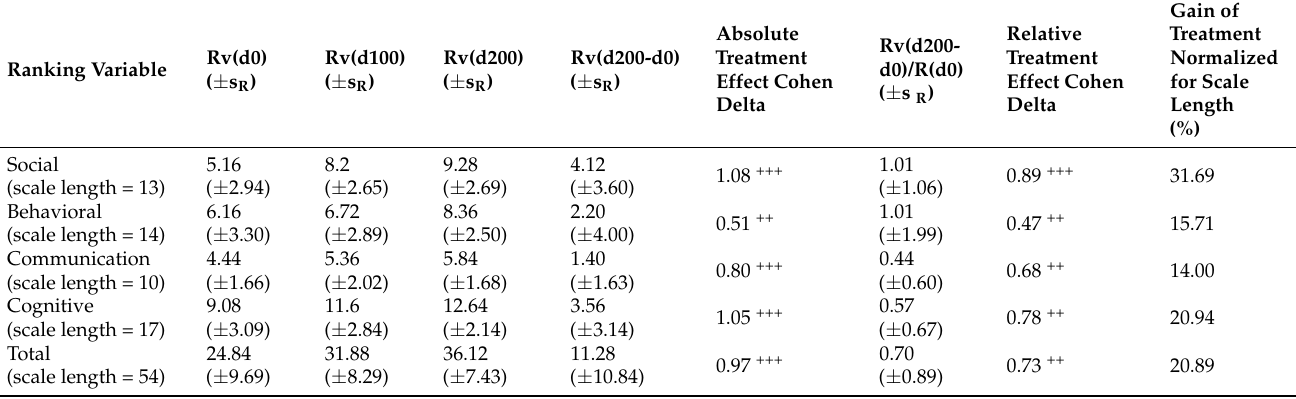
lowed by cognitive, communication, and behavioral skills. Methylcobalamin treatment led to changes in the observed clinical and psychological features and the number of responding subjects (represented by the slope, Figure 2), while